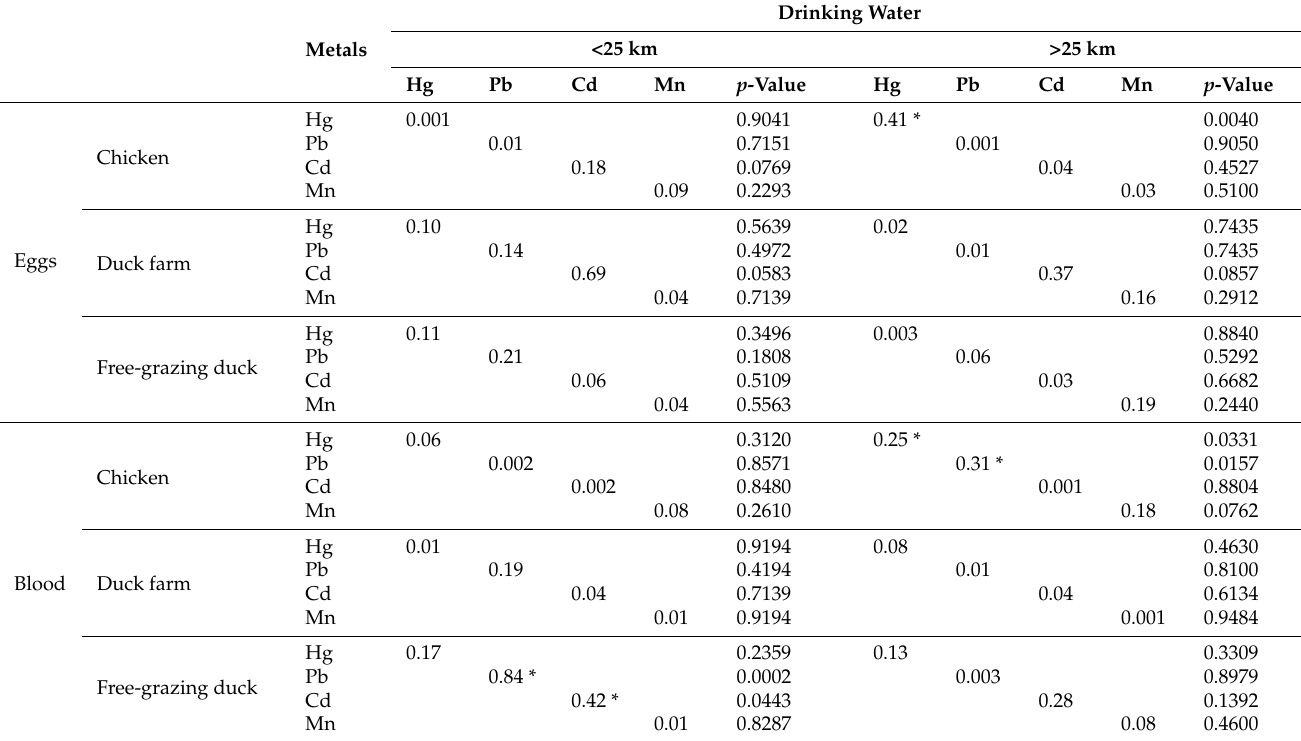
Table 6. Correlations between Hg, Pb, Cd, and Mn in eggs, blood, and drinking water (r 2 -value).